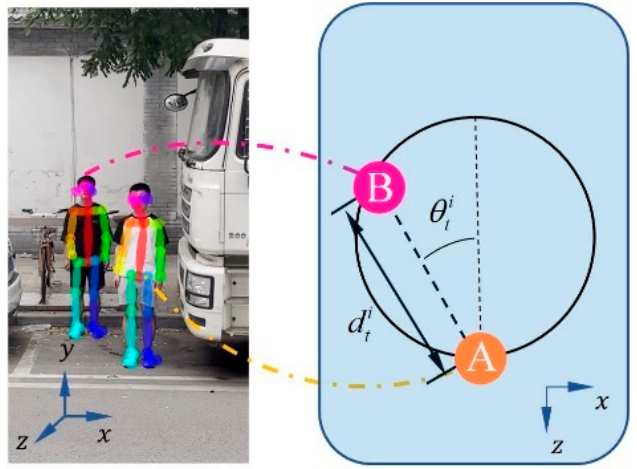
Figure 3. Schematic diagram of pedestrian distance and azimuth. On the XOZ plane, Points A and B represent the projections of pedestrians A and B, respectively.